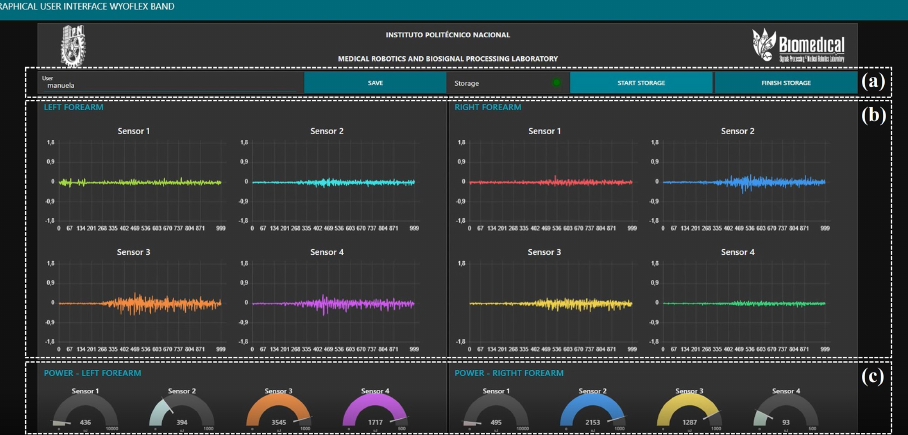
Figure 5. Graphical user interface developed in Node-RED. ( a ) Dialog box, ( b ) Plots for sEMG signals visualization, ( c ) Plots of sEMG signals